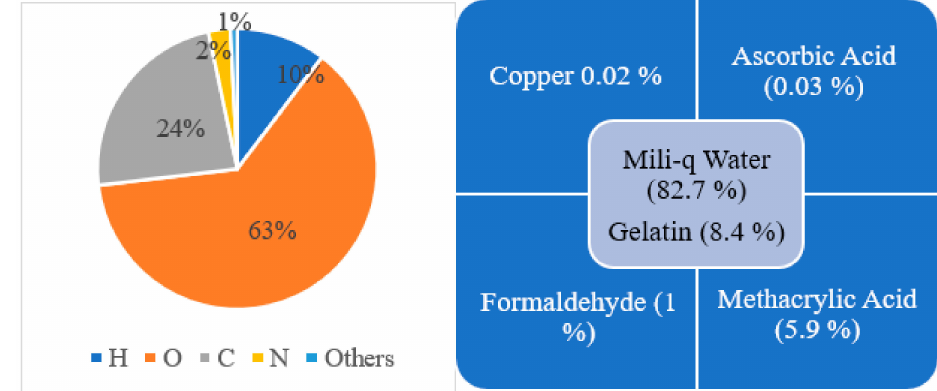
Figure 3. Atomic ( left side ) and chemical ( right side ) composition for MAGIC-f gel.